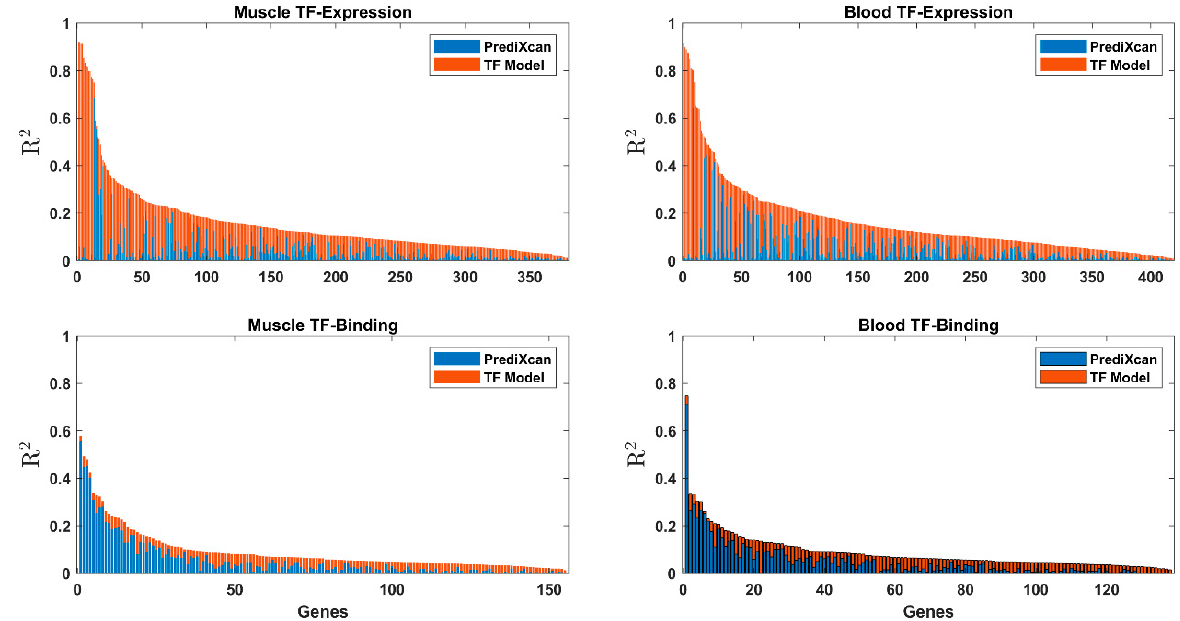
Figure 3. Stacked bar graph of the R 2 results of the cis baseline model (blue) and the skeletal muscle and whole-blood TF-expression and TF-binding (orange).